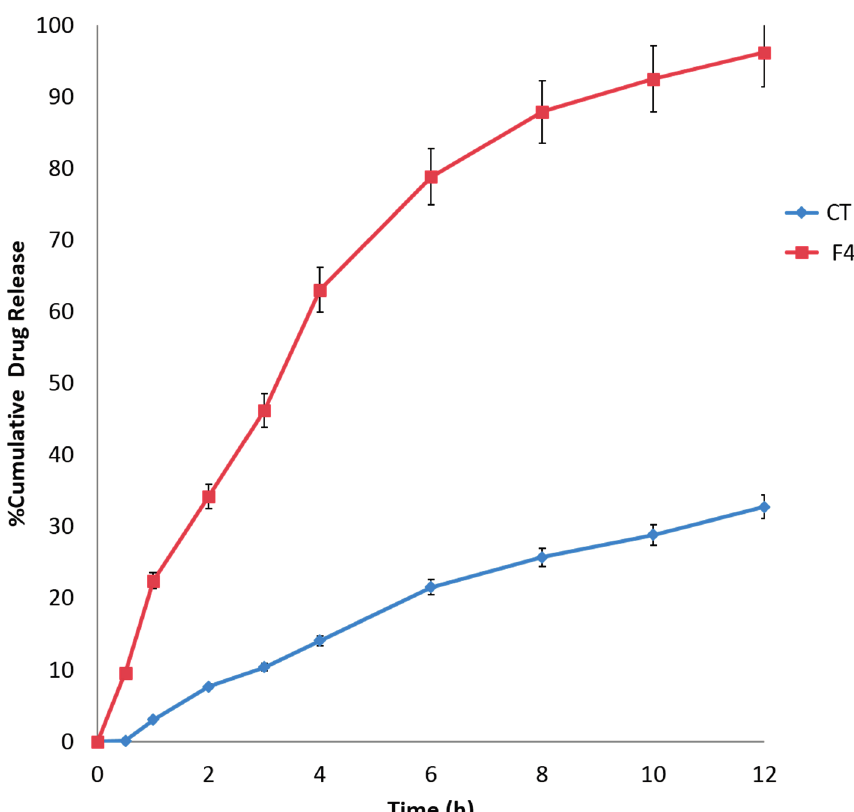
Figure 8. Percent Cumulative drug release profile of Gastro-retentive floating tablet of curcumin (CT) and F4 formulation in phosphate buffer, pH